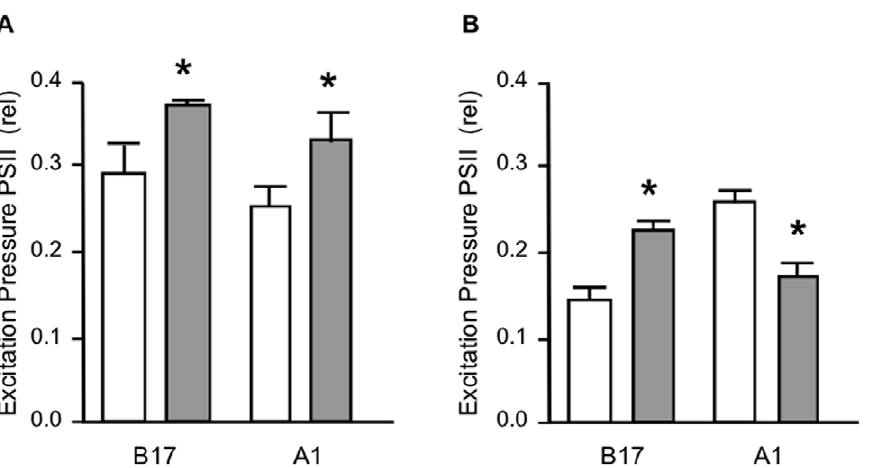
Figure 3. Excitation pressure over PSII. Symbiodinium cultures were exposed to high osmolarity conditions for ( A ) 1 hr or ( B ) 7 days, analyzed by fluorometry (see methods) and values for excitation pressure over PSII calculated for control conditions (white columns) or 9% PEG (gray columns). Symbiodinium types indicated on the ordinates. Results show the average from 3 independent experiments 6 SD (bars).